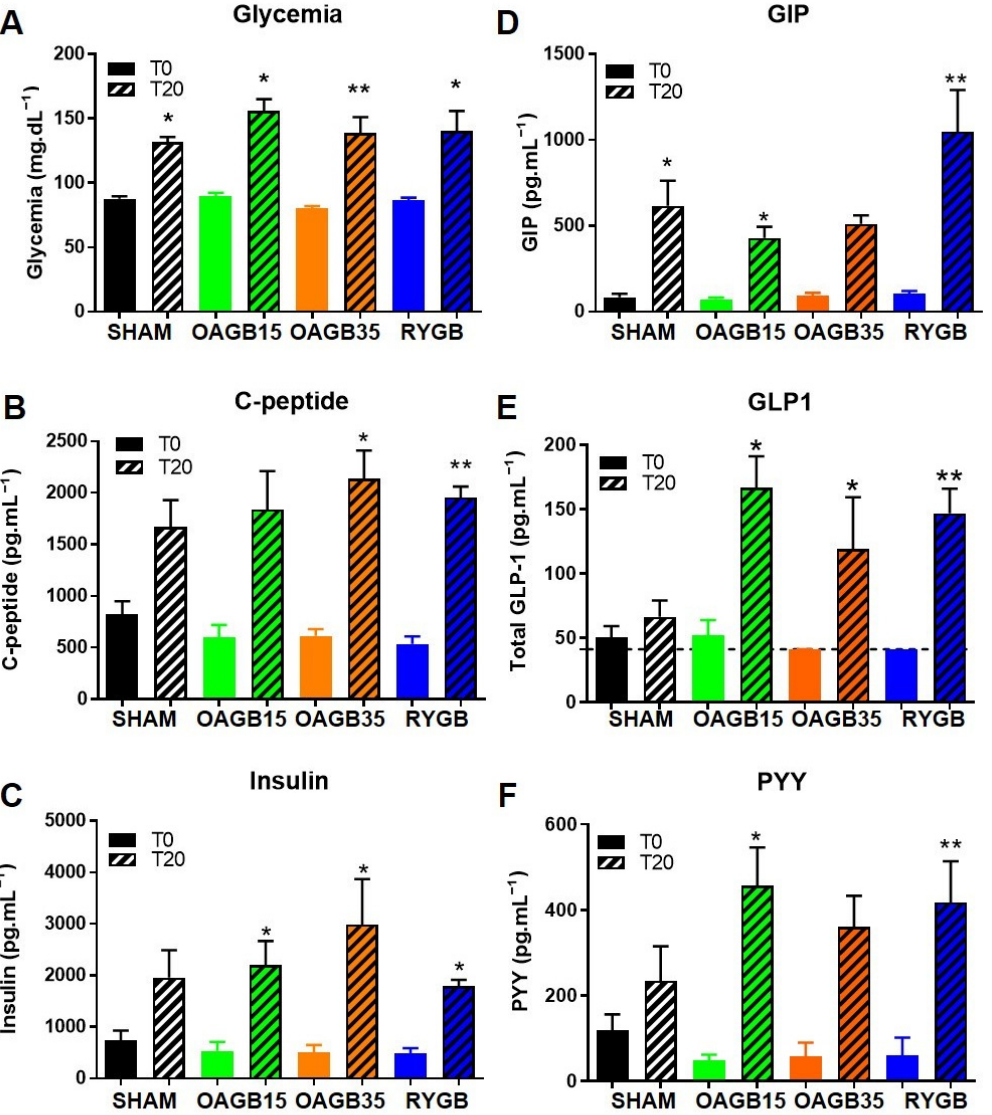
Figure 2. Shortening the BPL of OAGB preserves the altered secretion of pancreatic and gut hormones in response to a meal . Glycaemia ( A ) C-peptide ( B ), insulin ( C ), GIP ( D ), GLP1 ( E ) and PYY ( F ) levels in the plasma of rats before or 20 min after oral administration of a meal composed of glucose and lipids. * p < 0.05; ** p < 0.01, T20 versus T0 by Dunn’s multiple comparison tests after Kruskal–Wallis Test. Data are expressed as means ± SEM, SHAM n = 6, RYGB n = 6, OAGB15 n = 5, and OAGB35 n = 4.